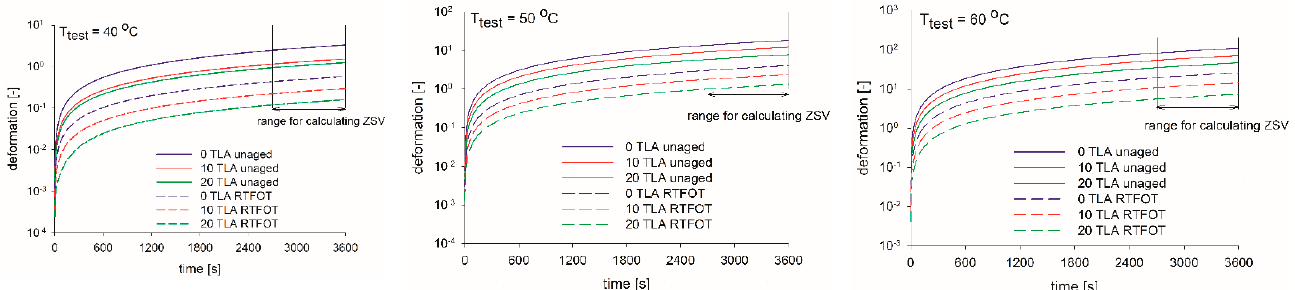
Figure 7. Measured and calculated viscosities versus the angular frequency on a log-log plot before and after aging at the specified test temperature. Table 6. Cross parameters of the TLA-modified binders before and after aging